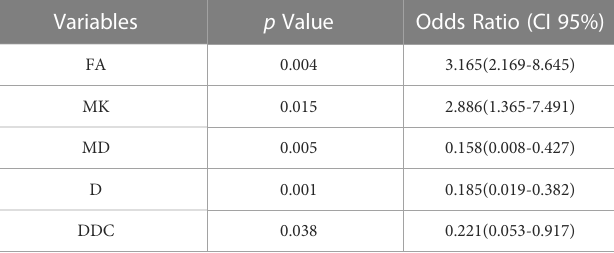
TABLE 4 Prediction for PCa among PI-RADS 3